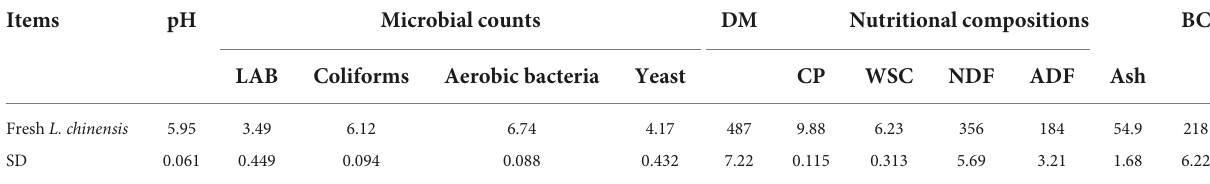
TABLE 1 The pH, microbial counts (log colony-forming units/g fresh weight), dry matter (DM, g/kg), nutritional compositions concentrations (g/kg DM), and buffering capacity (BC, mE/kg DM) in fresh Leymus chinensis ( n = 3).